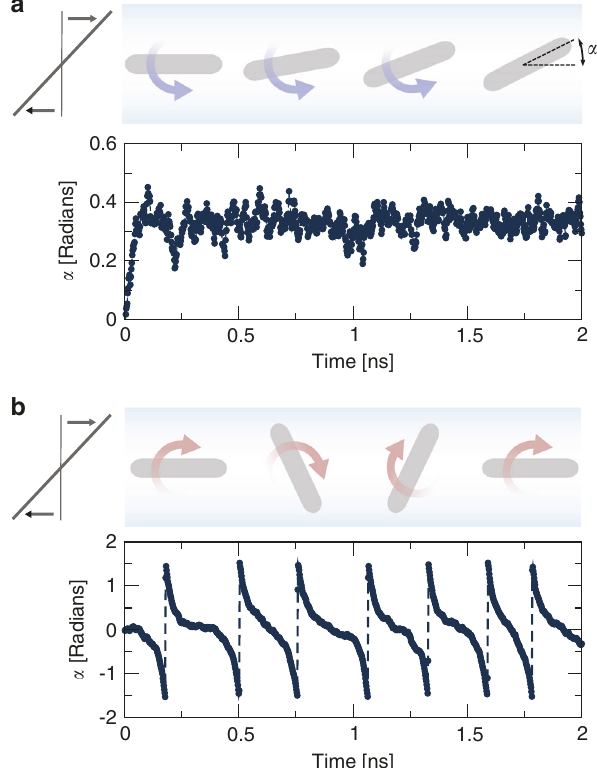
Fig. 2 Effect of slip platelet dynamics. a Top: according to our theory, a platelet with large hydrodynamic slip initially aligned with the fl ow will rotate in the opposite direction from that of the vorticity of the undisturbed fl ow and towards a stable inclination angle α c . Bottom: time evolution of orientation angle α from dynamic MD simulation of a freely suspended graphene bilayer, with half length a = 1.7 nm, aspect ratio b / a = 0.25, and slip length λ = (60 ± 5) nm. b Top: according to Jeffery ’ s theory, a platelet initially aligned with the fl ow will rotate continuously and in the same direction as the vorticity of the fl ow. Bottom: orientation angle α from MD simulation of a freely suspended no-slip platelet, with half length a = 1.8 nm, aspect ratio b / a = 0.2 and slip length λ ≈